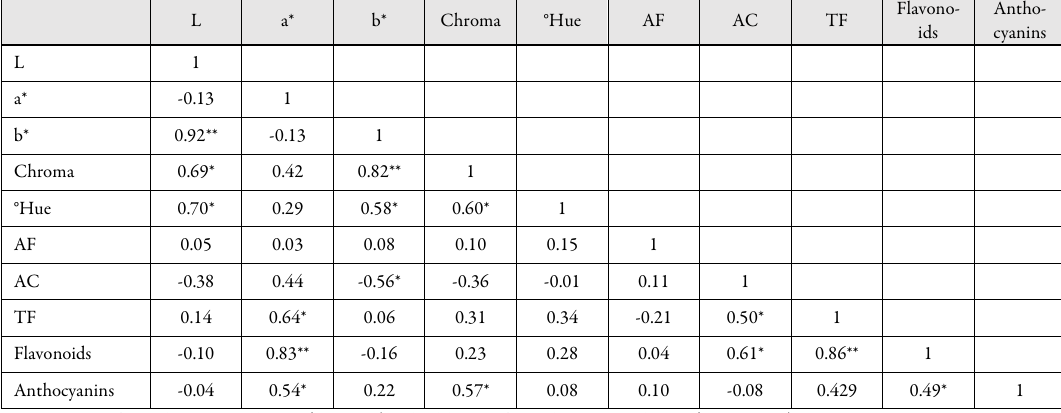
Table 9. Pearson correlation coefficients between color variables, nutraceutical compounds and antioxidant capacity of different varieties of common bean grown in Morelos State,